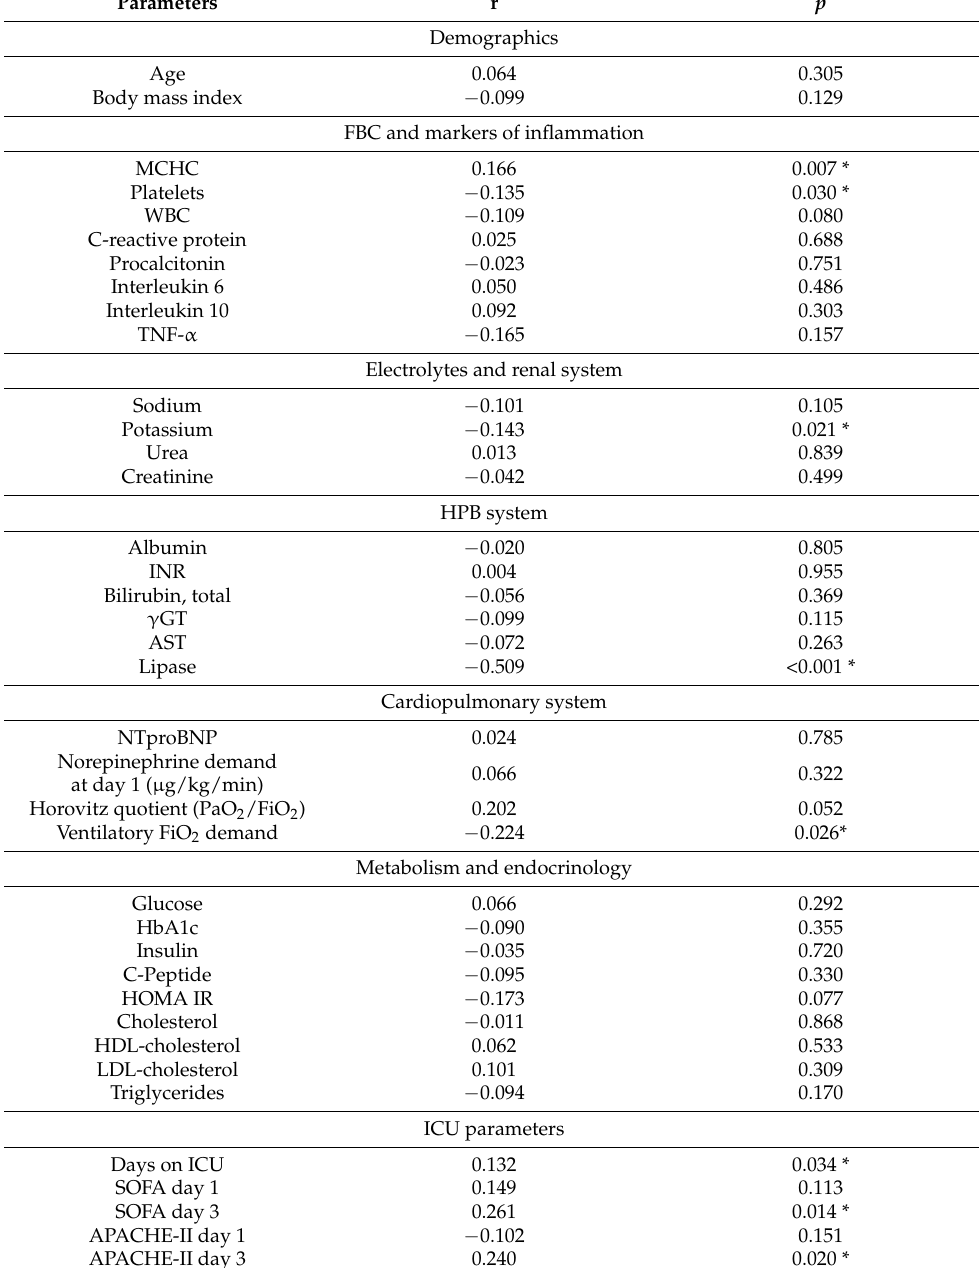
Table 1. Correlations of clinical and laboratory parameters with PLIN2 serum concentrations at ICU